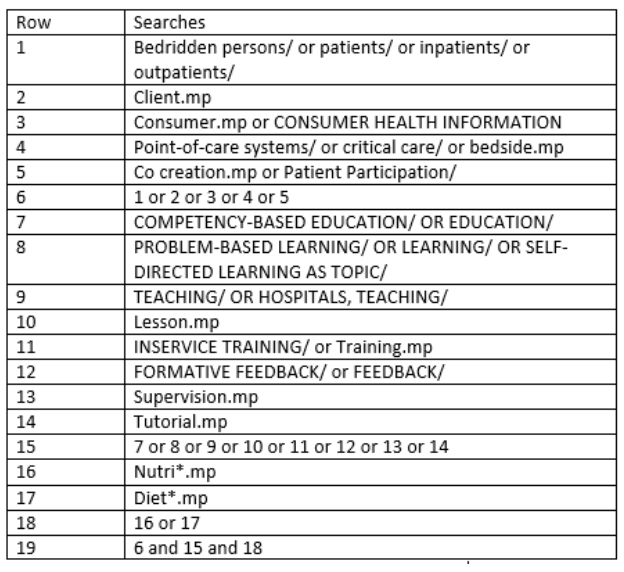
Figure 1. Database search strategy applied in Ovid MEDLINE. * indicates truncation.